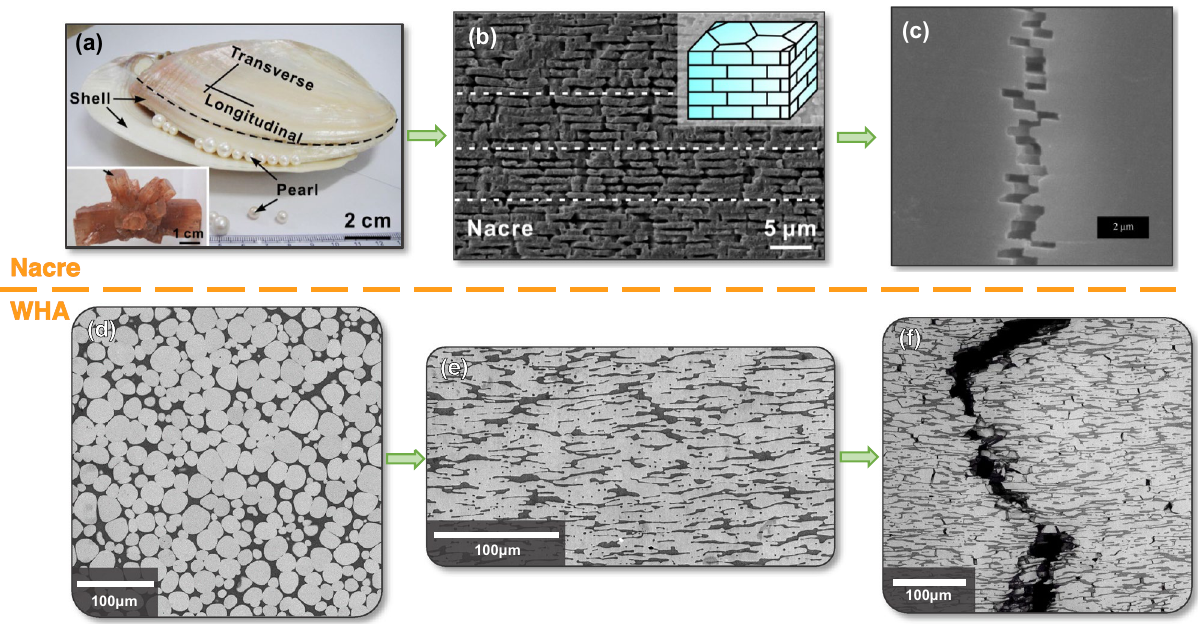
Figure 1. Comparison of naturally occurring nacre structures and their mechanical behavior ( a – c ) 22,23 to that of the brick-and-mortar rolled WHA ( d – f ). Figures ( a ) and ( d ) are low magnification overviews of these materials in their naturally occurring and industrially produced states, respectively, while ( b ) and ( e ) are views of the brick-and-mortar structure in nacre and the WHA after thermomechanical processing, respectively. Figures ( c ) and ( f ) are views of these structures post uniaxial tensile testing to highlight their remarkably similar deformation behavior. Figures ( a ) and ( b ) are reprinted from Ref. 22 with permission from Elsevier, and figure ( c ) has been reprinted from Ref. 23 with permission from